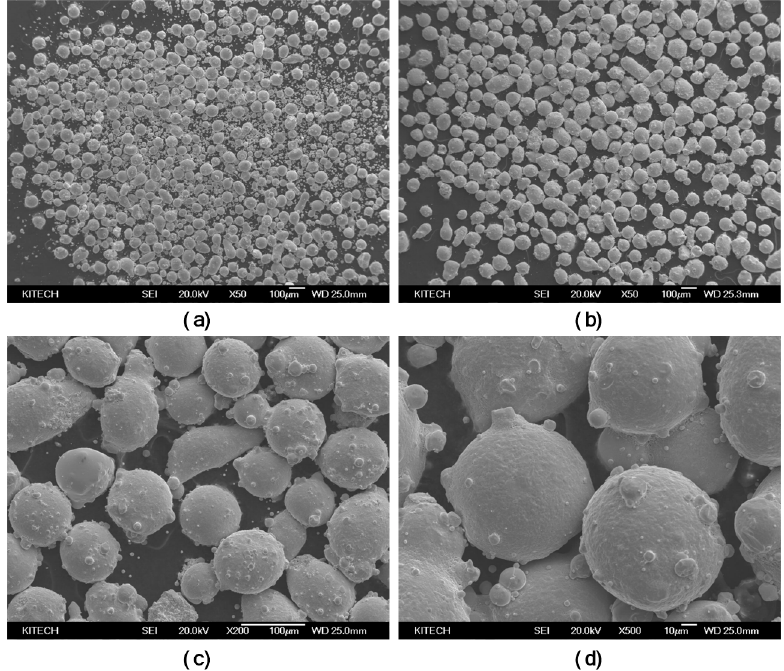
Figure 2. SEM images of samples before and after sieving of the high wear resistance steel ( HWS ) powder: ( a ) Powder states before sieving; ( b ) Powder states after sieving; ( c , d ) Particle shape of satellite powder.